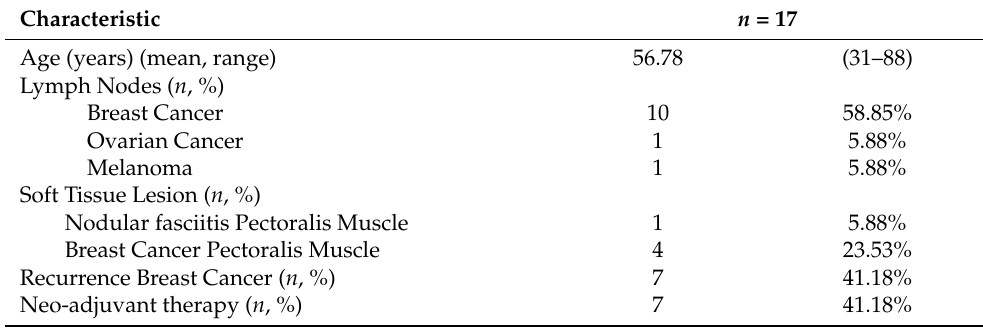
Table 3. Baseline characteristics of patients with resected soft tissue lesions and lymph